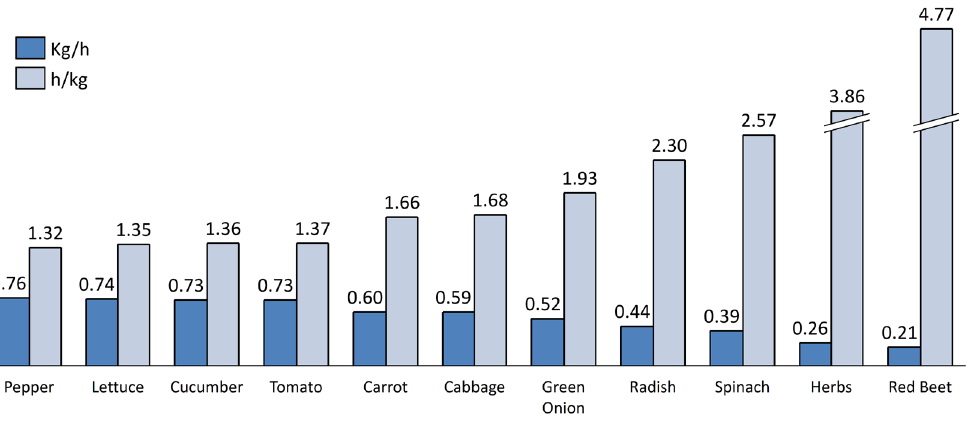
Figure 19: Diagram of h/kg-ratio and kg/h-productivity ratio for all target plants. All three fruit bearing crops (tomato, pepper, and cucum- ber) have the lowest work effort-to-biomass output ratio. Average values are 0.62 kg/h or 2.5 h/kg respectively for all